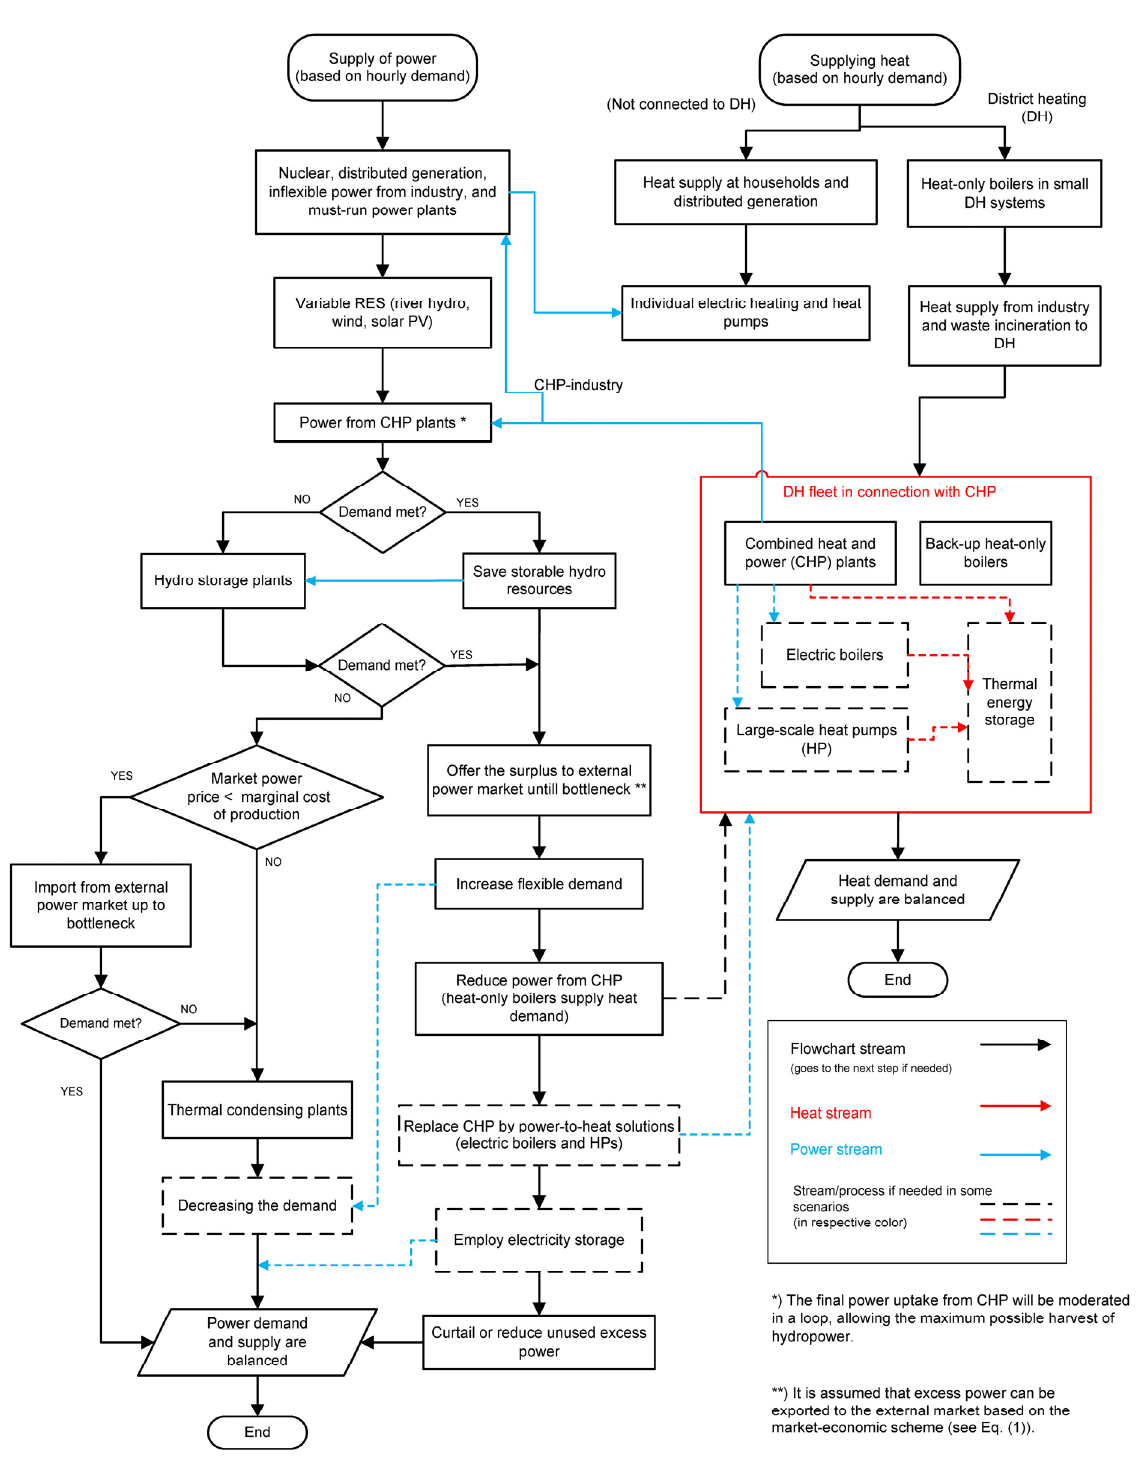
Figure 1. Schematic scheme of the model in supplying power and heat in an integrated method based on hourly distributions of demand and market prices of electricity—This procedure is translated into a set of regulation strategies to be run by